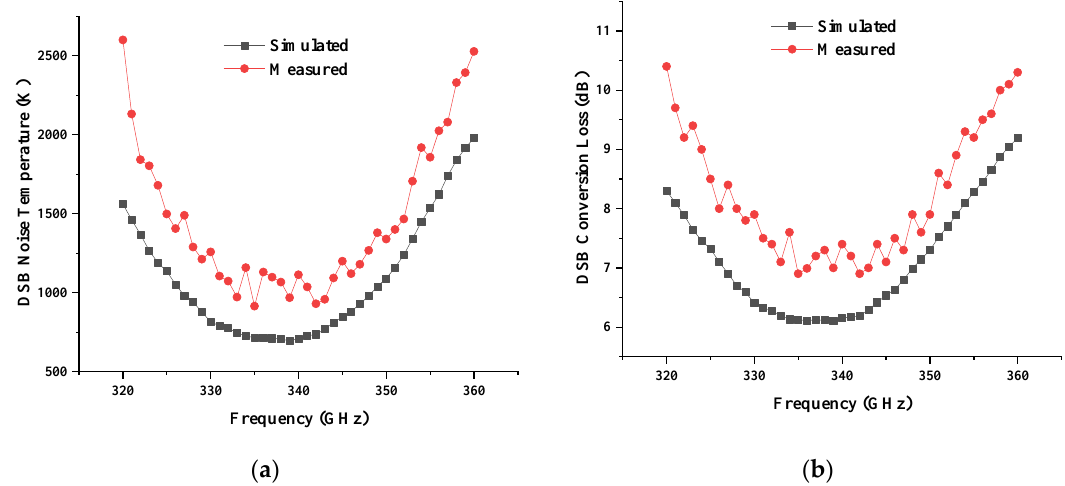
Figure 16. Simulated and measured performances of 0.34 THz SHM from 320 GHz to 360 GHz ( a ) double sideband (DSB) noise temperature and ( b ) DSB conversion loss.